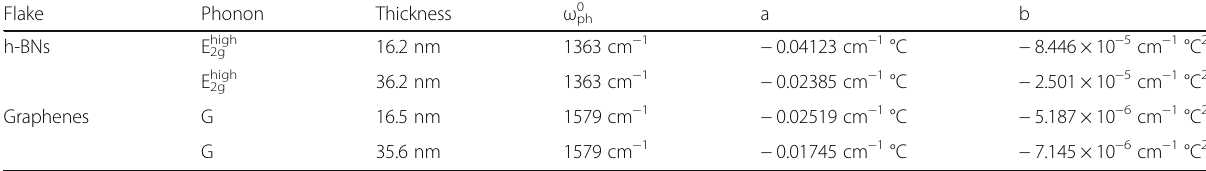
Table 1 Temperature dependence of Raman frequency of E 2ghigh peak and G peak are fitted by ω ph = ω ph0 + at+bt 2 , and the constants of ω ph0 , a, and b are given in the table Flake Phonon Thickness